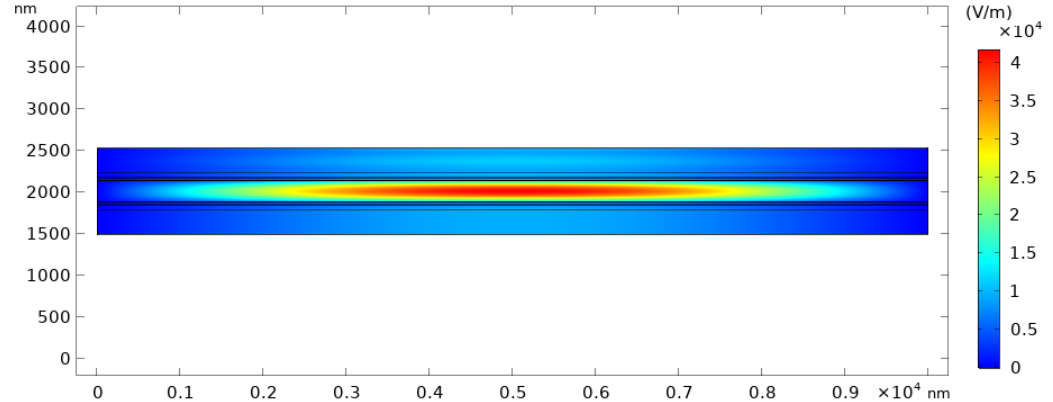
Figure 7. Electric field distribution in the filter with gap value of 260 nm at resonance wavelength of 625 nm.